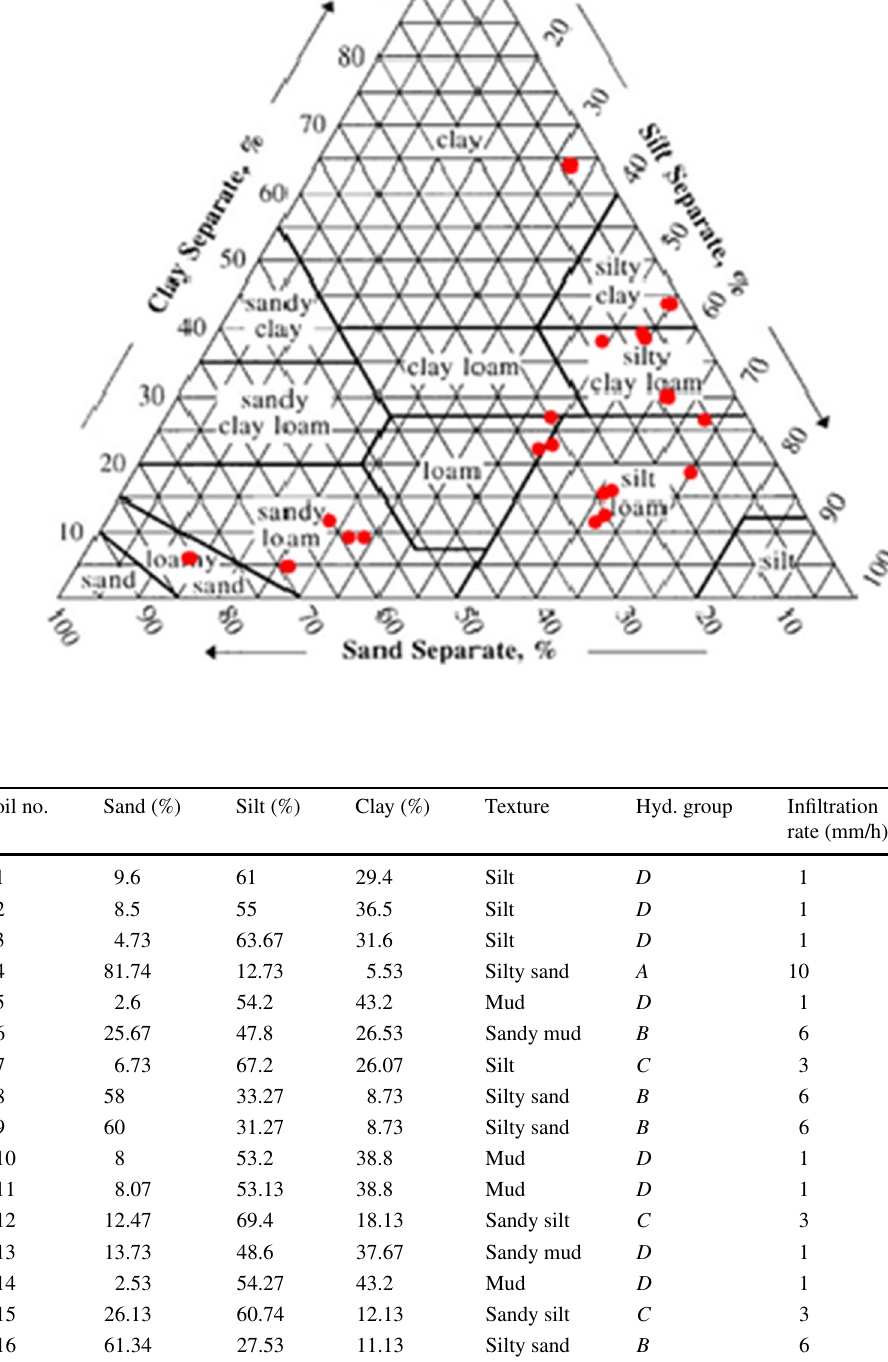
Fig. 8 Soil texture of the soil samples (USDA online web)